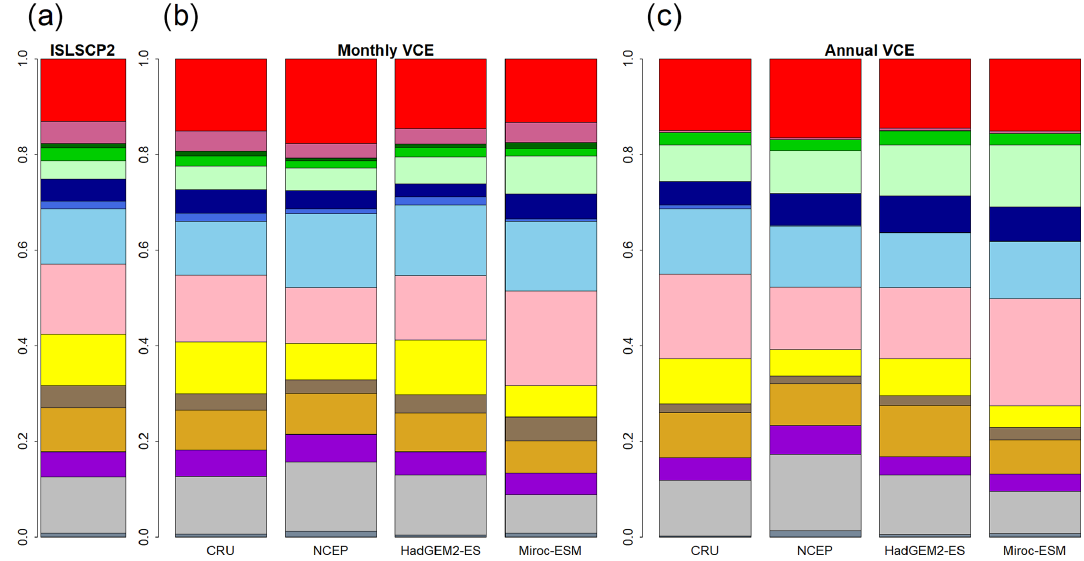
Figure 2. Global biome compositions of the observation-based map (a) and simulated maps from CNN models trained by monthly mean climate (b) and annual mean climate (c) of CRU climate data spanning from 1971 to 1980. These CNN models were adapted to four climatic datasets (CRU, NCEP, Had2GEM-ES and MIROC-ESM) spanning the same period of the training data.